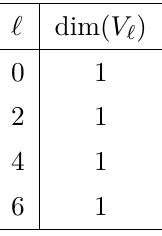
Table 1. Limit IV 1